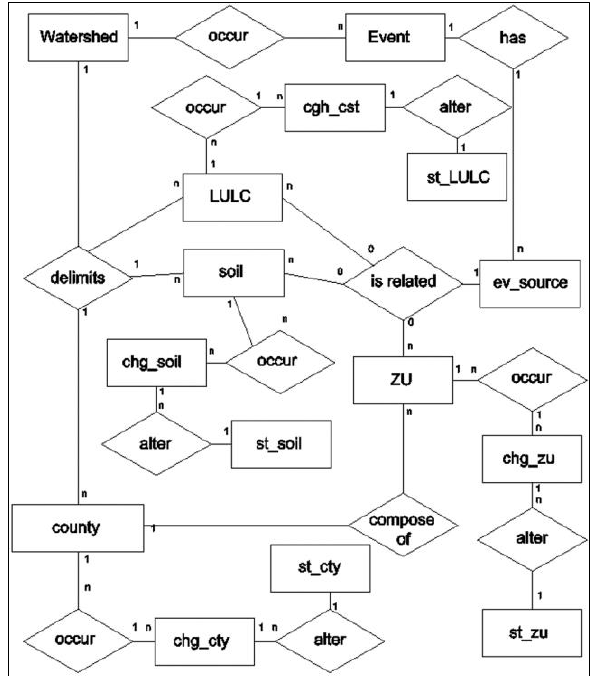
Figure 3: Diagram of